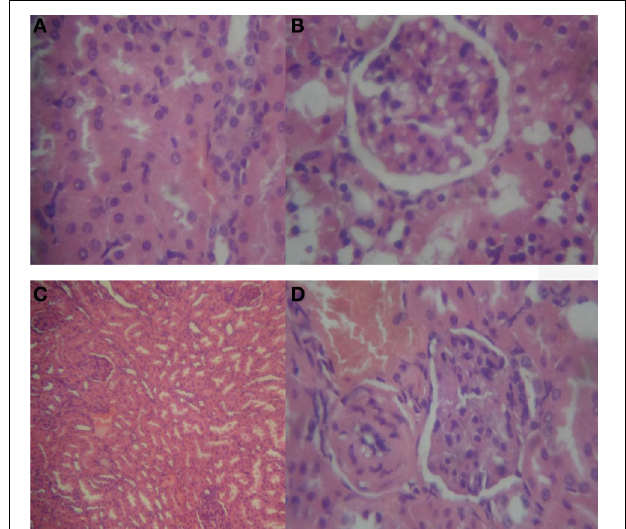
FIGURE 5 | Representative sections of rat liver in respect of reversibility study. (A) Normal rat liver showing normal hepatocytes and hepatic vasculature; (B) 20mg/kg/day HLE-FP-treated rat liver showing epithelial proliferation and scattered areas of vascular congestion; (C) 100mg/kg/day HLE-FP-treated rat liver showing scattered areas of vascular congestion; and (D) 500mg/kg/day HLE-FP-treated rat liver showing few local lymphocytic aggregates with mild-to-moderate vascular congestion ( × 100 magnification).